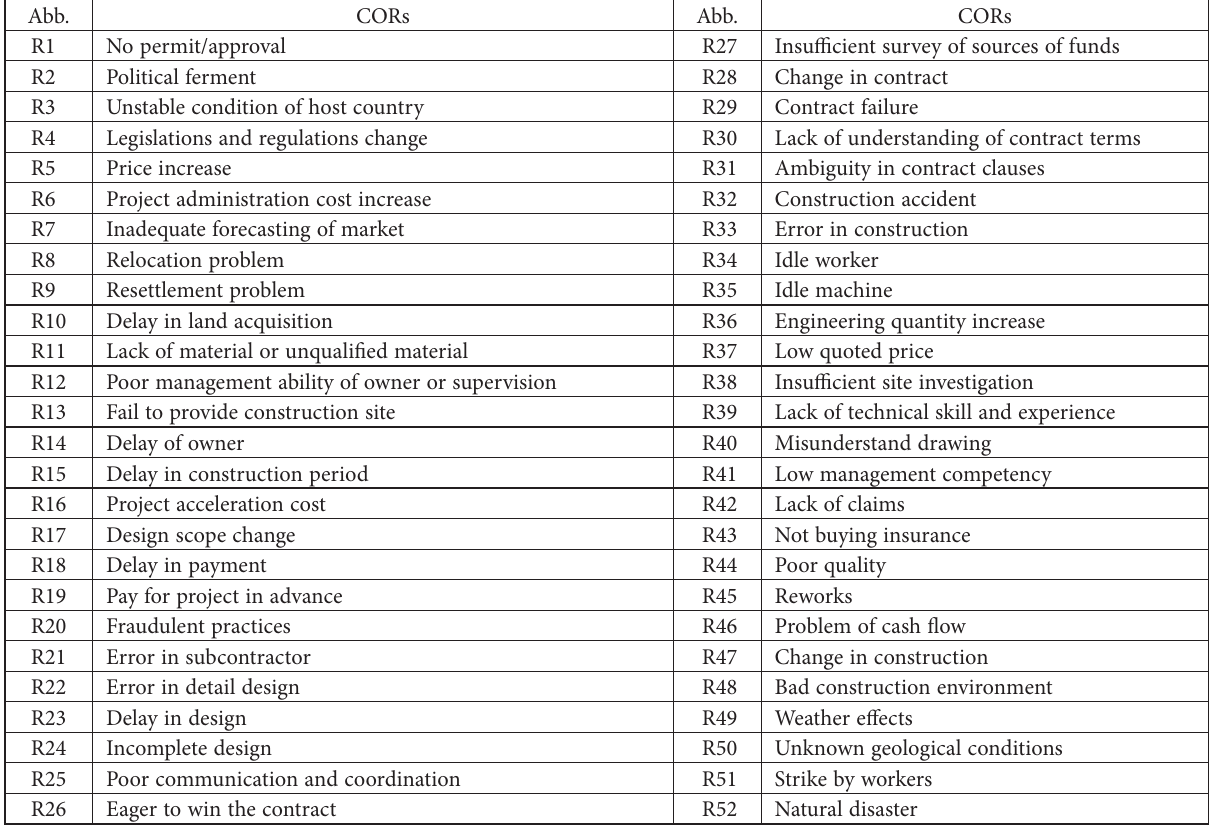
Table 4. All CORs identified by engineering case analysis